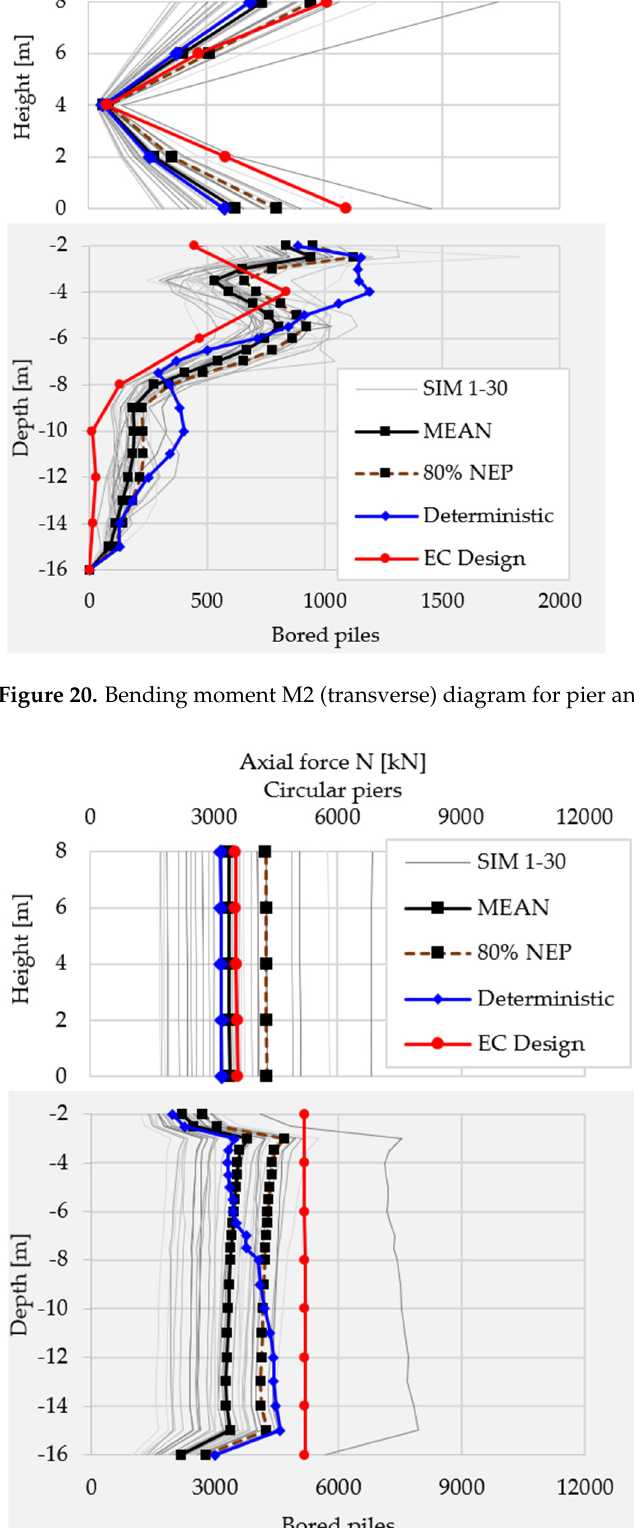
Figure 21. Axial force N diagram for pier and bored piles.